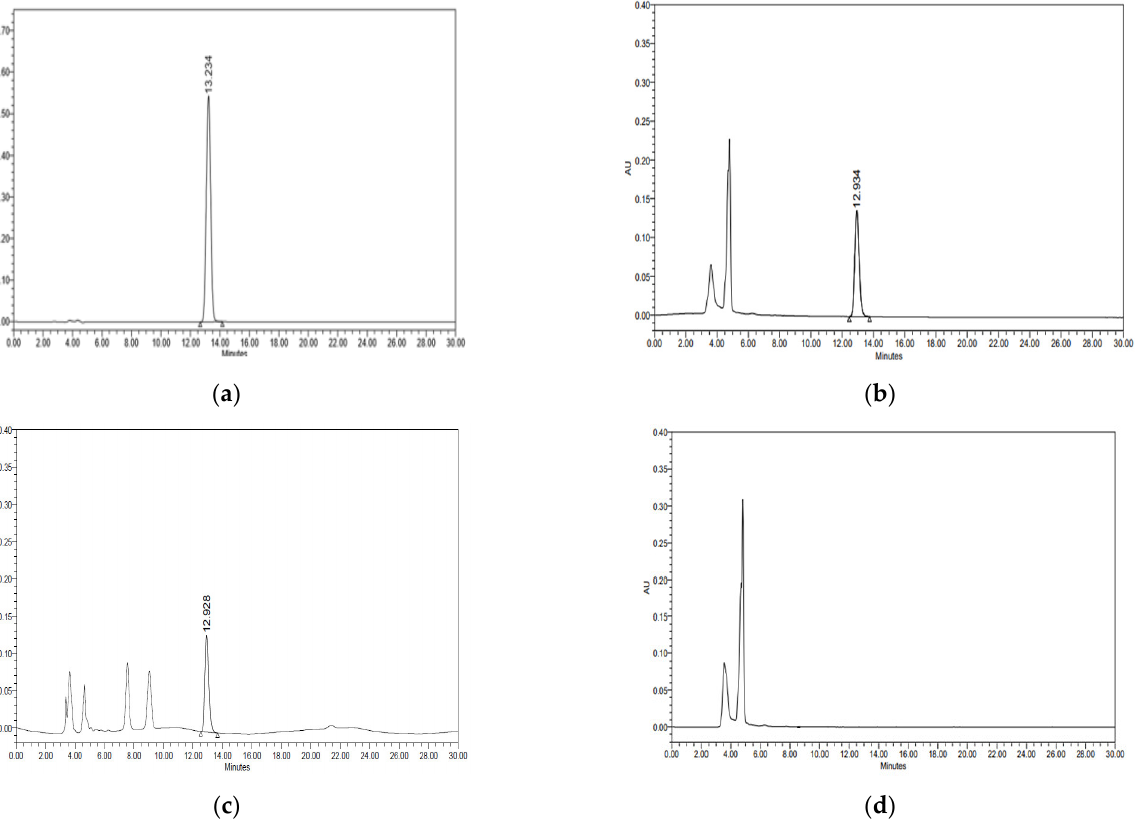
Figure 3. Chromatogram and spectrum of thiabendazole as determined by high-performance liquid chromatography–photodiode array (HPLC–PDA) detection. ( a ) Thiabendazole standard. ( b ) Solid sample spiked with thiabendazole. ( c ) Liquid sample spiked with thiabendazole. ( d ) Blank sample. Table 3. Coefficient of determination (R 2 ) of the calibration curves, limit of detection (LOD), and limit of quantification (LOQ) of the analytical method for thiabendazole in the solid and liquid food samples.